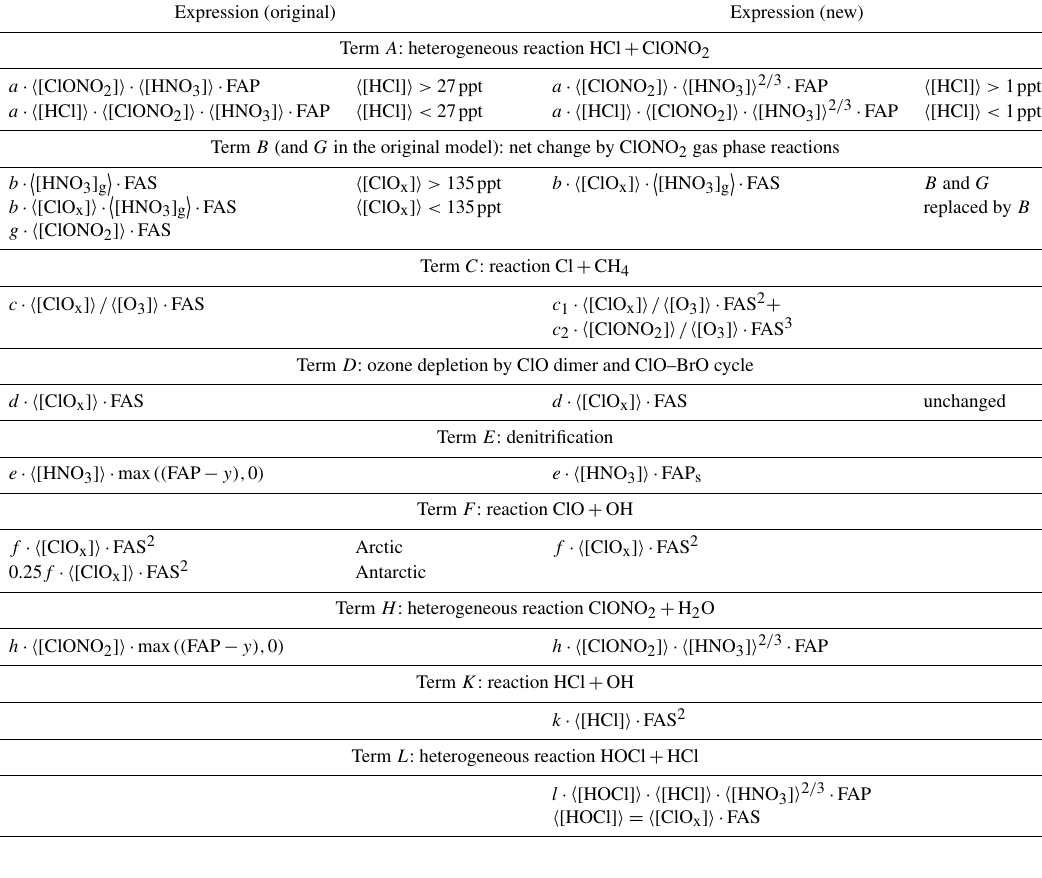
Table 2. List of the terms used in the differential equations in the original and new Polar SWIFT version. (cid:104) ... (cid:105) is the vortex mean. a to l and y are free fit parameters. FAP and FAP s are fractions of the polar vortex below different threshold temperatures for the formation of PSCs (see Sect. 2.5). FAS is the fraction of the vortex exposed to sunlight (see Sect.2.5).